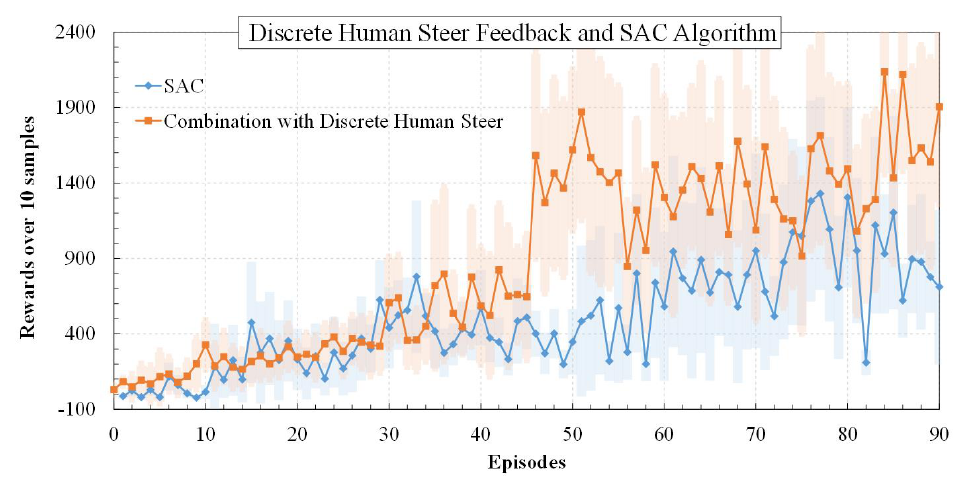
Figure 4. A comparison of baseline SAC with the proposed method engaged with discrete human feedback from steer averaged over 10